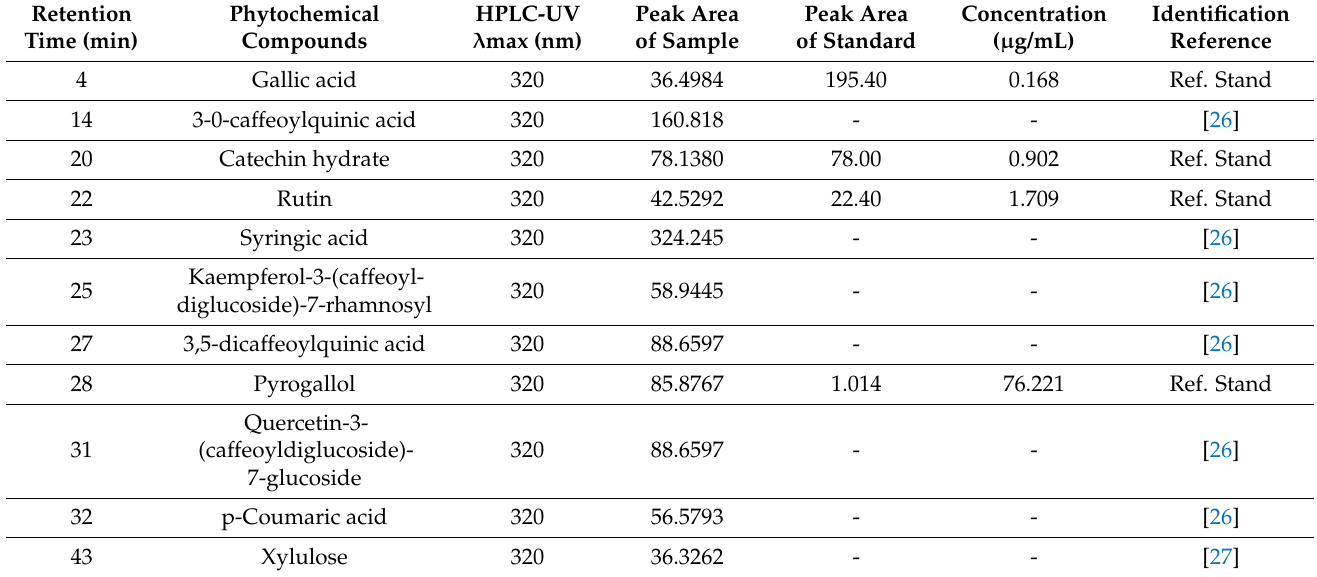
Table 4. Identified phytochemicals in purified fraction B of A. articulata through the HPLC-UV technique.